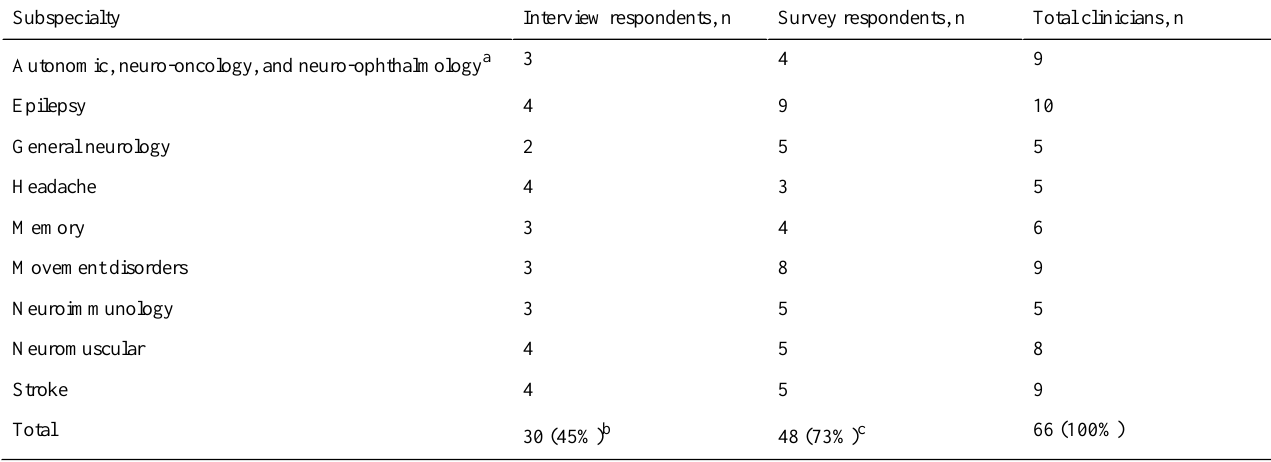
Table 2. Number of ambulatory neurology clinicians who completed the video visit survey and were interviewed, by subspecialty.